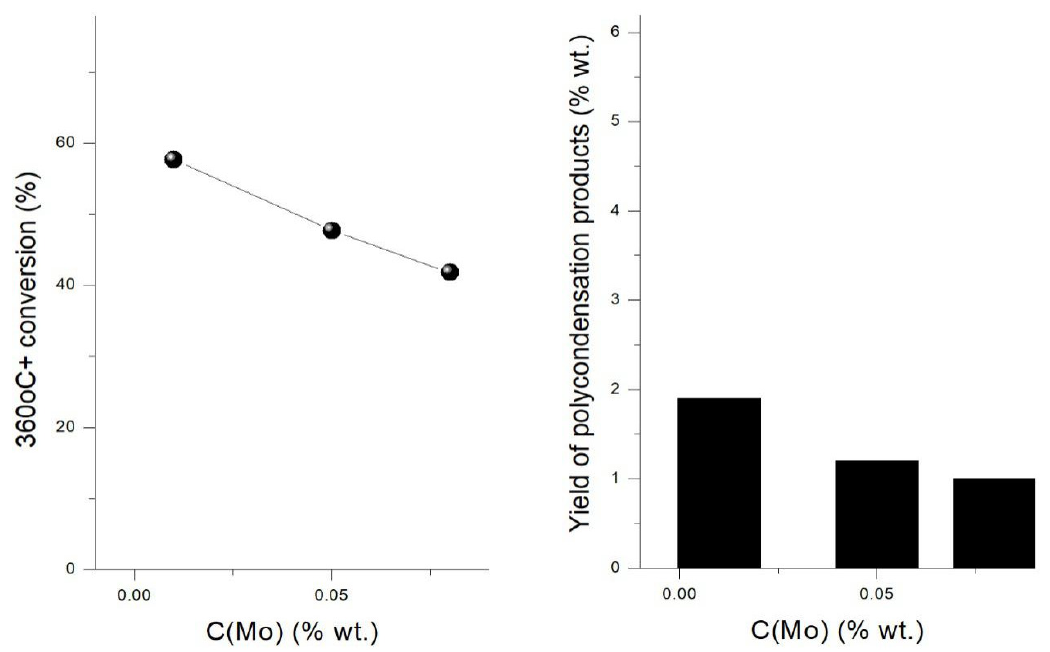
Figure 3. Dependence of 360 °C+ conversion and polycondensation products yield on the catalyst precursor loading. In test #2 (C(Mo) = 0.05%wt.) and test #3 (C(Mo) = 0.08%wt.), the in-situ formed cat-